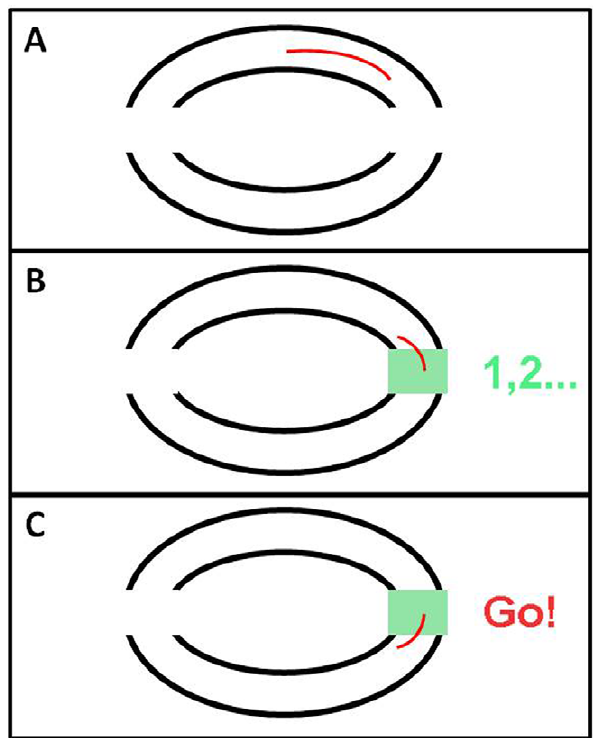
Figure 2. The display on the screen in TDB trials. (A) Two white squares at the two movement extremes (B) When the participant’s movement trace reached an end-point, the corresponding square become green. (C) After a 2-sec pause, the word ‘‘Go!’’ appeared, and the participant was required to make another discrete movement.